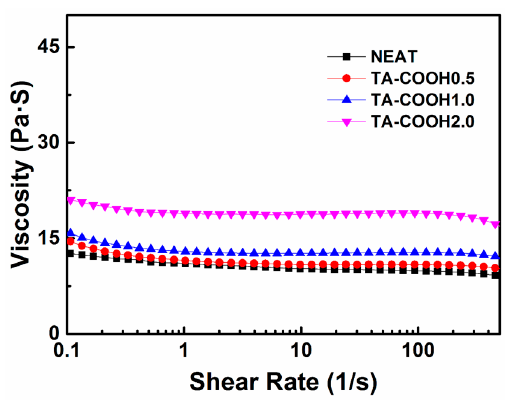
Figure 2. Viscosity versus shear rate of neat epoxy and TA–COOH modified epoxy resins.